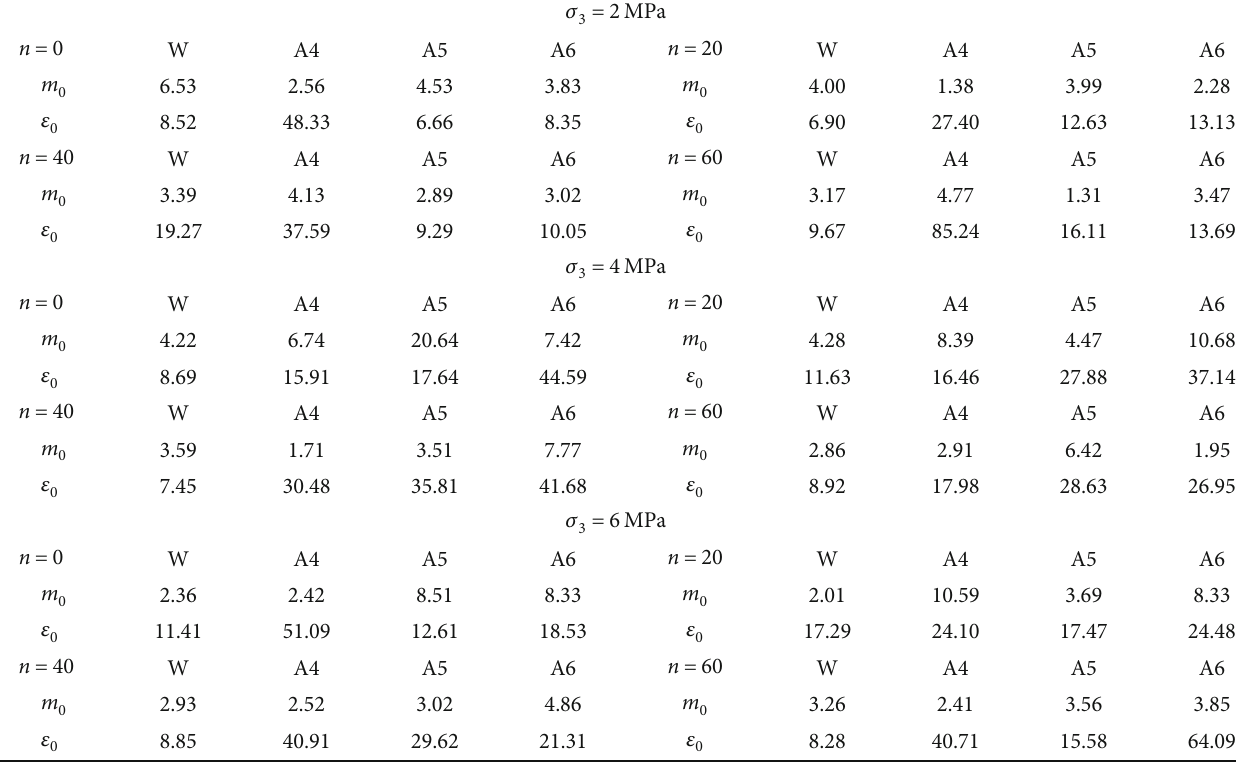
ε 0 and 0 for each experimental